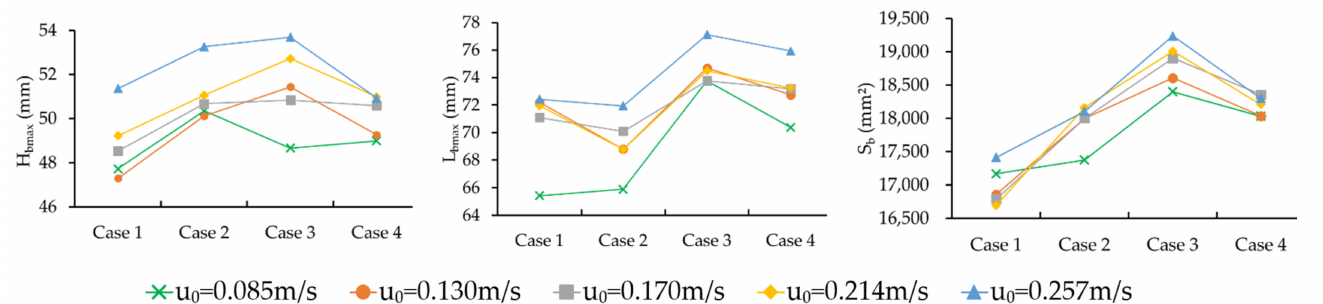
Figure 10. Characteristic values of the back vortex region recorded for M-shaped unit reefs under different configurations: H bmax , L bmax , S b